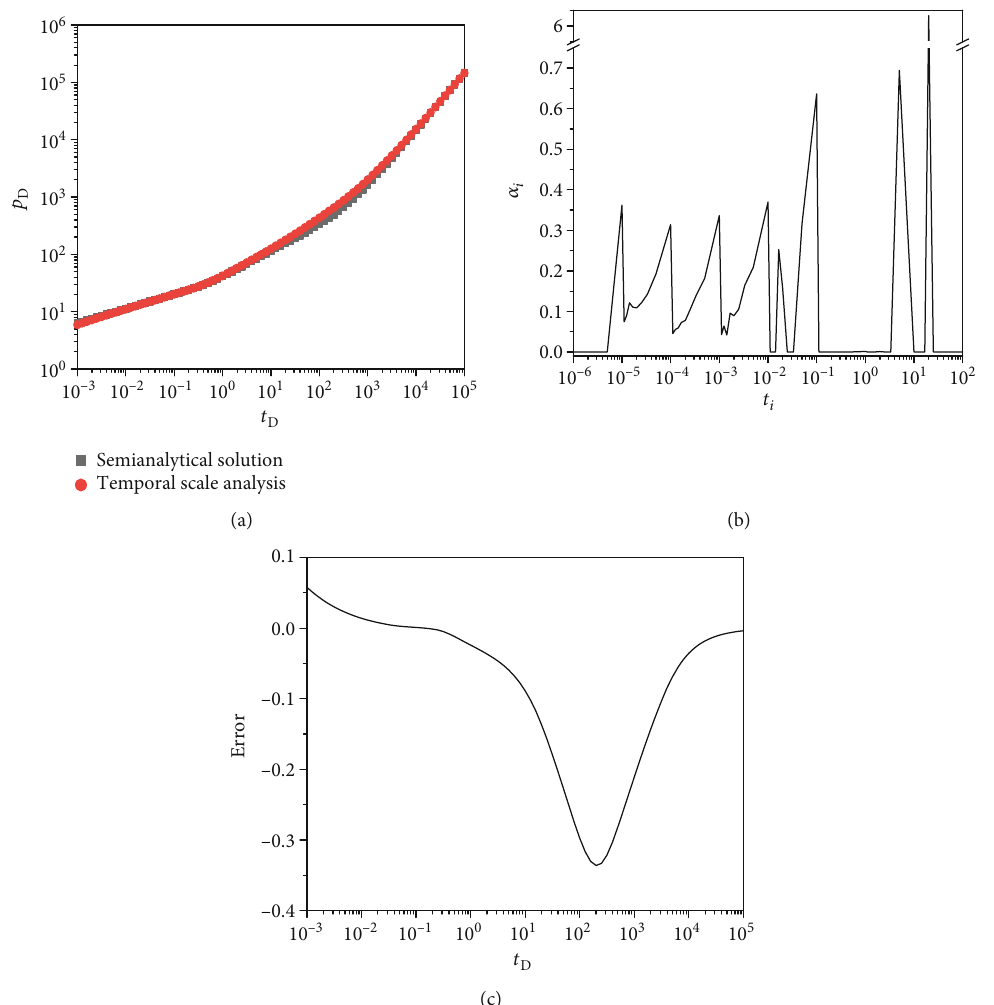
Figure 4: Model validation: (a) wellbore pressure, (b) temporal scale distribution, and (c) error analysis.